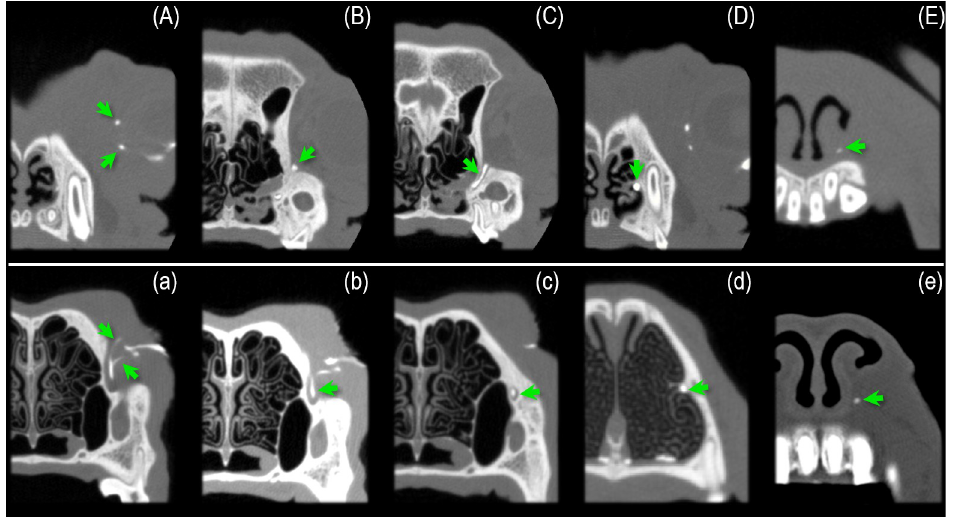
Fig 2. The NDS of a brachy- and normocephalic dog in CT cross-sectional images. The picture illustrates the different, contrast medium-filled parts of the NDS in CT cross-sectional images. Figures (A)—(E) show a French bulldog, (a)—(e) a normocephalic mixed breed dog in comparison. (A) and (a) focus on the lacrimal canaliculi. It is noticeable that the canaliculi in the brachycephalic dog, due to their backward course, are shown in cross-section (punctiform), while in the normocephalic dog they are shown in longitudinal section. (B) and (b) depict the lacrimal sac. While the lacrimal sac in the normocephalic dog appears as a well delineated, drop-shaped structure, in the French bulldog it is clumsy and poorly demarcated. (C) and (c) show the nasolacrimal duct (NLD) within its bony canal. The different course of the NLD is also noticeable. (D) and (d) illustrate the middle portion of the NLD below the basal lamina of the ventral nasal concha. Here the NLD has a larger diameter than the initial part. (E) and (e) show the end portion of the NLD as it runs deep below the mucous membrane just before it emerges from the lacrimal foramen. Please note that in the French Bulldog different parts of the NDS are visible within one CT cross-sectional image. This is never the case with the images of the normocephalic dog. Pictures (A) and (D) show both the canaliculi and the middle portion of the NLD. Image (B) depicts the lacrimal sac and the end of the initial part of the NLD.